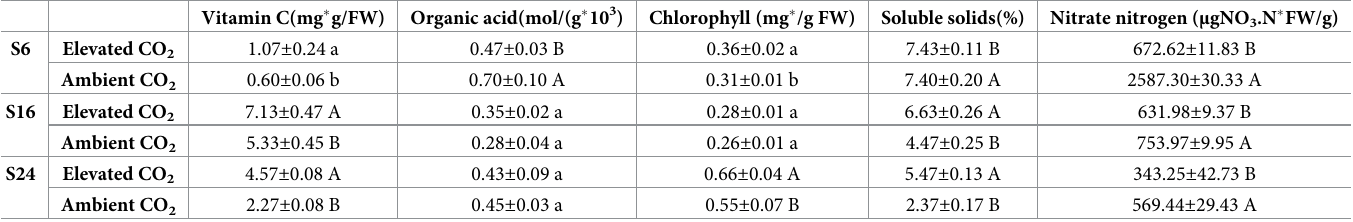
Table 3. Effect of elevated CO 2 on the lettuce quality.